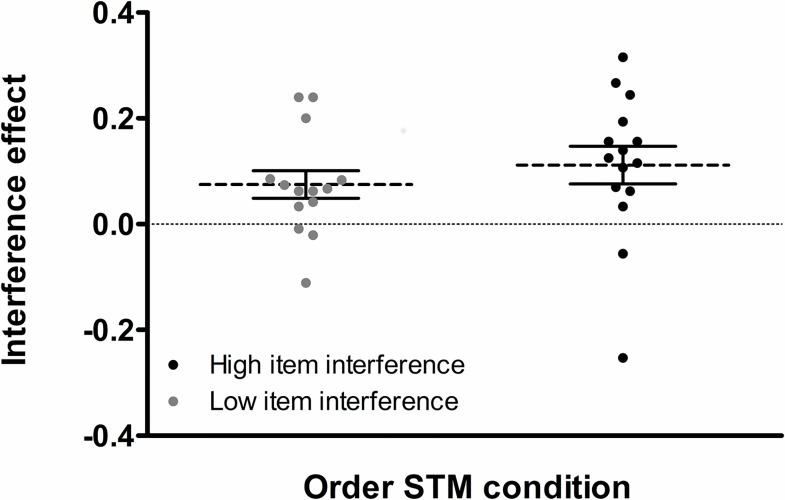
Relative effect of interference in Experiment 2.The distribution of the relative effect of interference (dashed and solid lines for means and standard errors, respectively) is shown for the order STM condition (collapsed across the two stimulus domains), as a function of item STM interference group (low item STM interference effect versus high item STM interference effect). Note that the two groups were determined based on a median split applied on the size of the interference effect observed in the item condition.